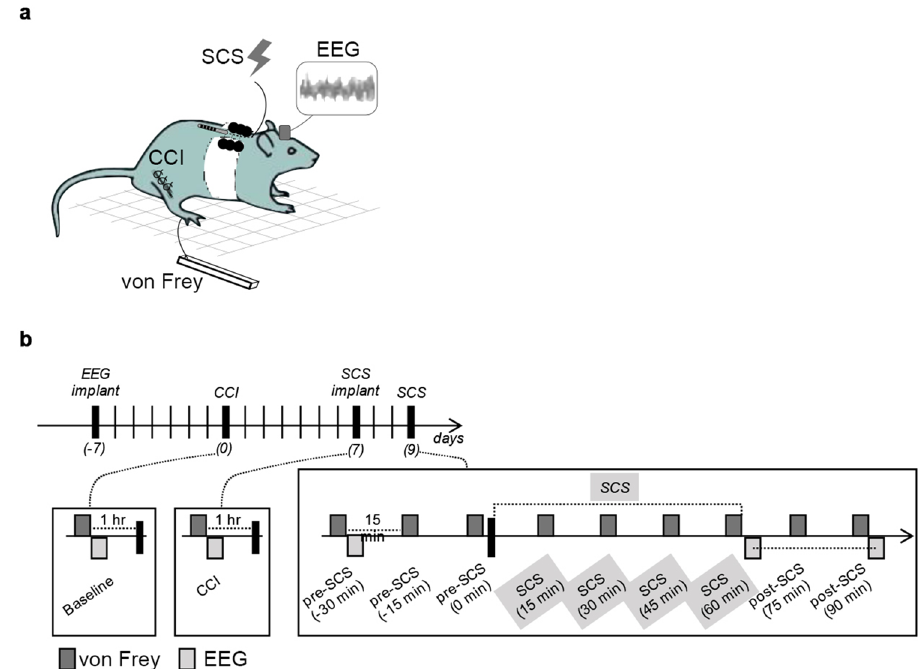
Figure 1. ( a ) Experimental paradigm. ( b ) Timeline of experiments. Rats first undergo implantation of EEG electrodes and are allowed one week for post-operative recovery. Second, seven days after EEG implant, CCI is done and allowed one week for post-operative recovery. Third, seven days after CCI, SCS implant is done, and allowed one day of recovery. Fourth, one day after lead implant, rats undergo SCS. For testing the analgesic effects of SCS, von Frey and EEG data are collected prior to, and at several time points during and after,